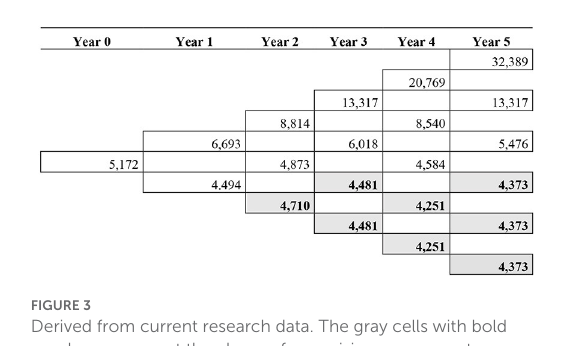
FIGURE3 Derived from current research data. The gray cells with bold numbers represent the change from raising sugarcane to growing soya; the given values show the contribution margin per hectare.